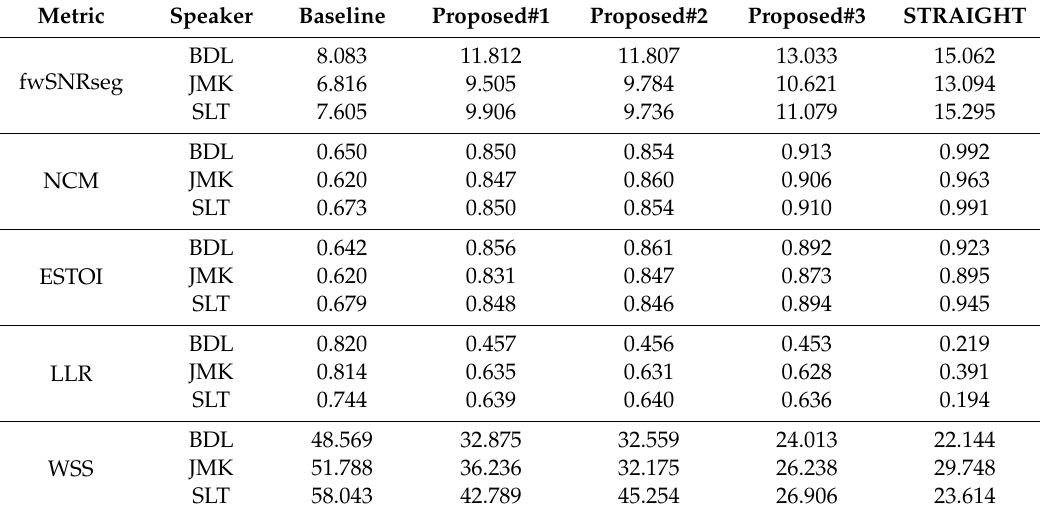
Table 5. Average scores performance based on synthesized speech signal per each